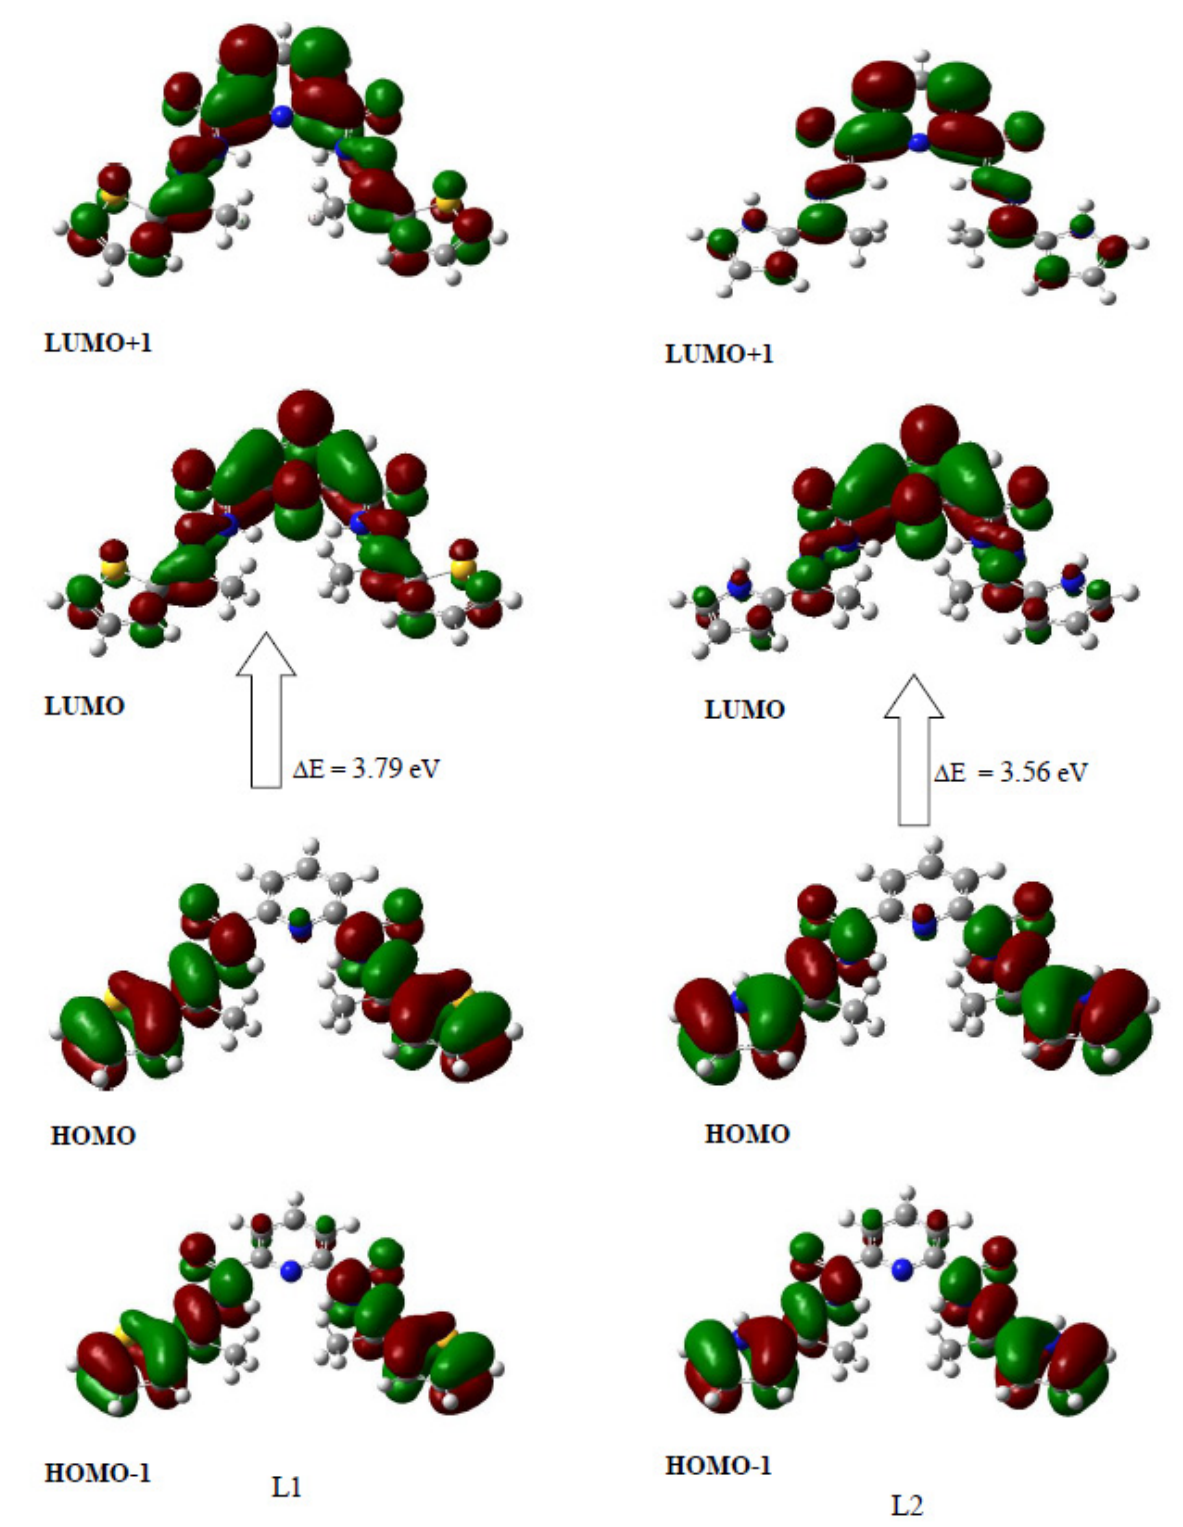
Figure 4. Frontier molecular orbitals (HOMO, HOMO-1, LUMO, and LUMO+1) of L1 and L2.